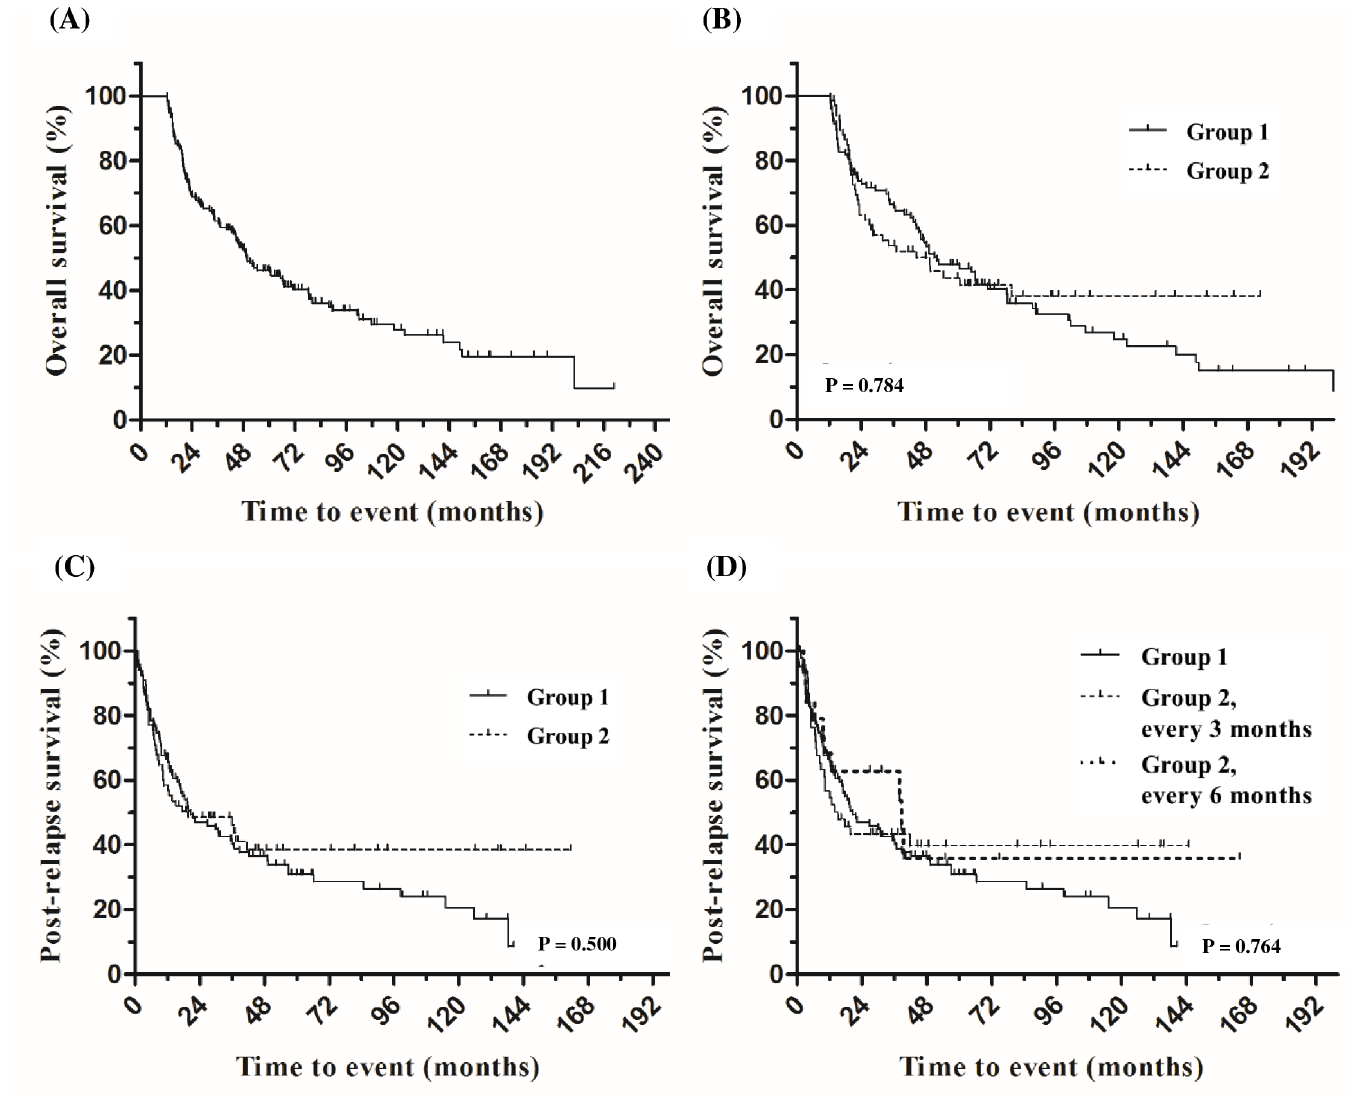
Fig 2. Kaplan-Meier curves of overall survival and post-relapse survival in relapsed aNHL patients after achieving complete remission with frontline chemotherapy. (A) Overall survival in 171 patients who relapsed after achieving complete remission with frontline therapy. (B) Overall survival according to relapse detection method. (C) Post-relapse survival according to relapse detection method. (D) Post-relapse survival according to interval of surveillance computed tomography (CT) scan. Group 1: Relapse detected by a method other than CT (symptoms, physical examination, or blood tests). Group 2: Relapse detected by surveillance CT.